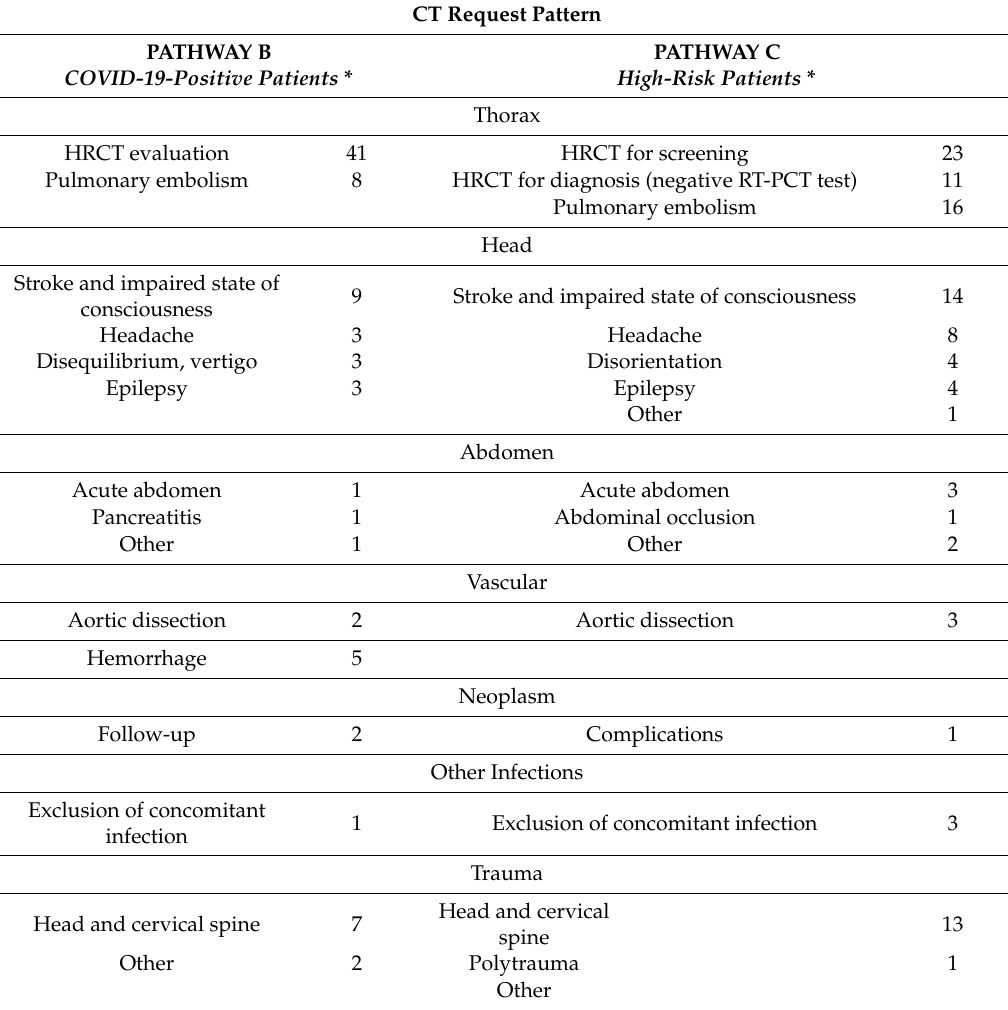
Table 1. Number of computed tomography examinations performed in our tertiary center for Pathways B and C (high-risk and COVID-19-positive patients) during the COVID-19 pandemic subdivided according to the request